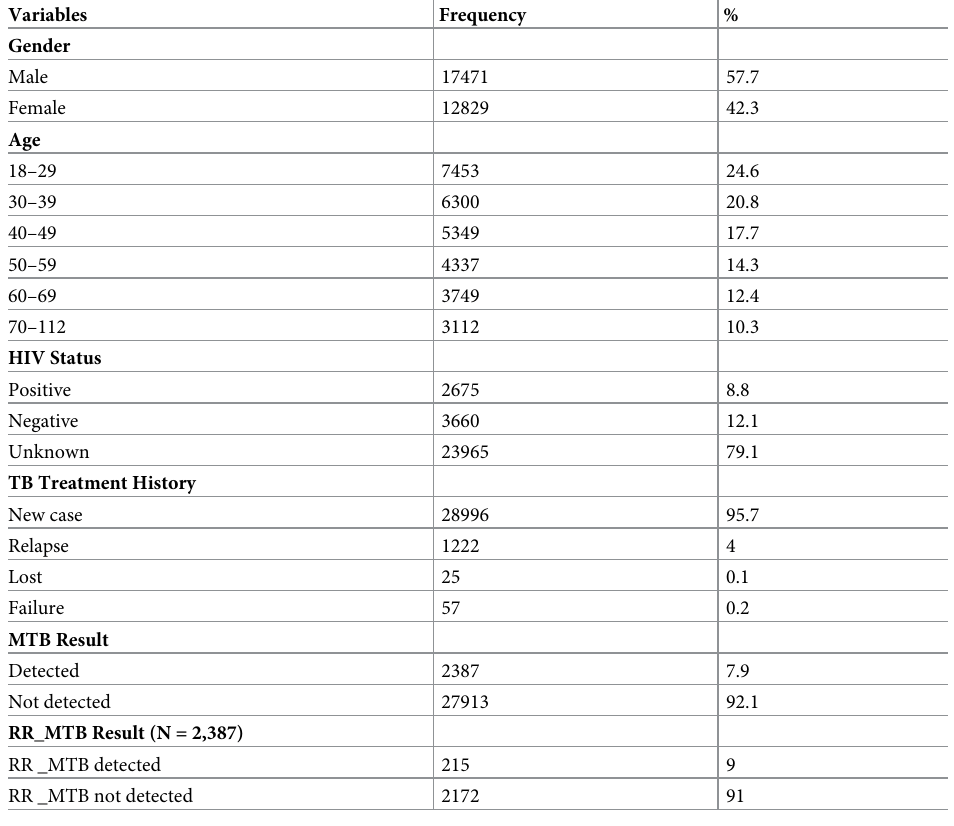
Table 1. Socio-demographic, clinical characteristics and MTB result among presumptive adult patients in East- ern, Mekelle and Southern Zones of Tigray, Ethiopia, 2016–2019 (N = 30,300).